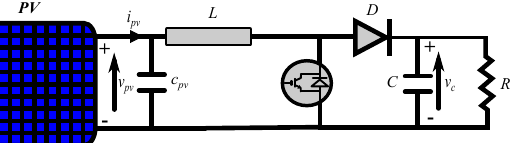
Figure 1. The configuration of the PV system with boost